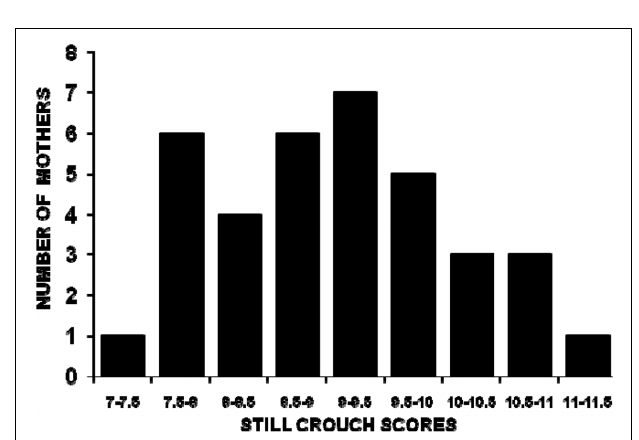
FIGURE 1 |The distribution of mean hourly pup-licking scores (maximum possible score/h = 20) for 36 C57BL/6J mothers over five 1-h observations (two light phase, three dark phase) on postpartum days 2, 4, 6, and 8.